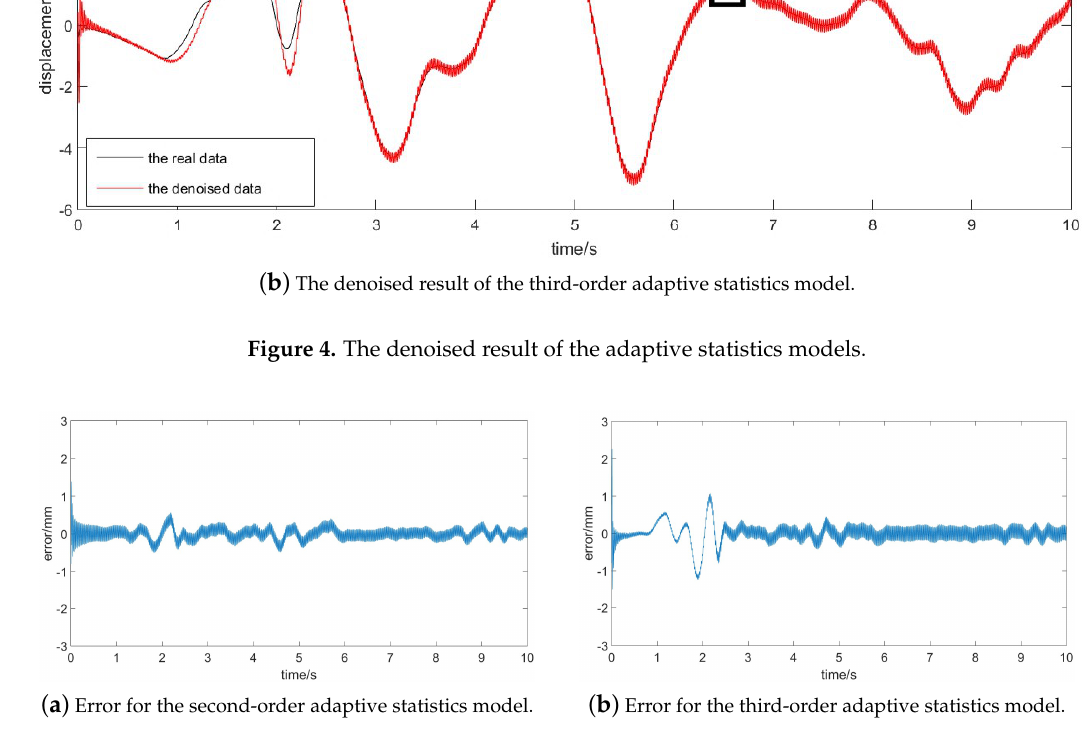
Figure 5. The error comparison of the adaptive statistics models for online